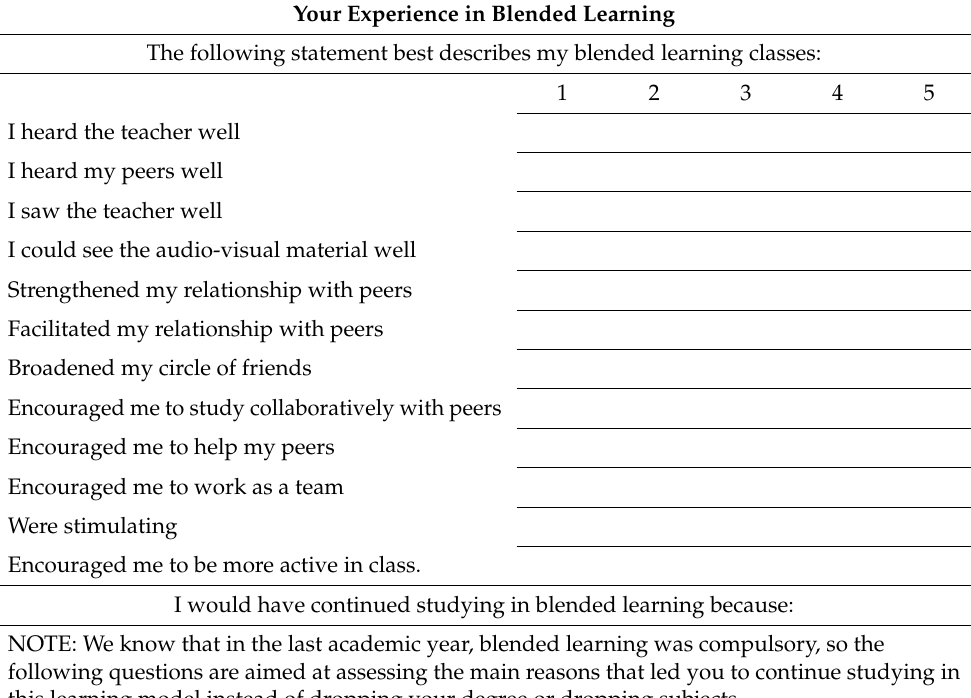
Your Experience in Blended